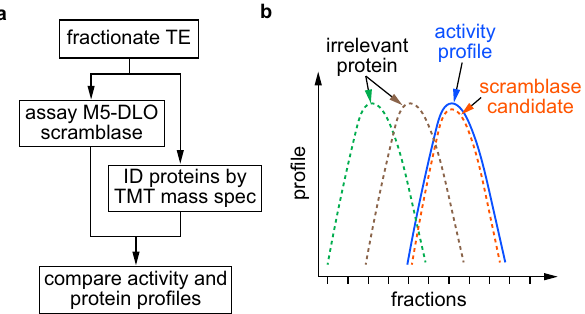
Figure 2. Principle of the activity correlation profiling approach. ( a ) A Triton X-100 extract (TE) of salt- washed yeast membranes, i.e. an extract that is enriched in ER membrane proteins, is fractionated by velocity gradient sedimentation. Half of each fraction is reconstituted into large unilamellar vesicles and assayed for M5-DLO scramblase activity as outlined in Fig. 1b to generate a profile of scramblase activity across the gradient. The remaining half of each fraction is subjected to mass spectrometric analysis using the tandem mass tag (TMT) system. Thus, each fraction is digested with trypsin, and the resulting peptides are labeled with TMT multiplex reagents (a unique TMT mass tag is used for each fraction). The digests are pooled and analyzed by tandem mass spectrometry to quantify the relative amount of identified proteins across fractions, thereby generating protein profiles. The protein profiles are quantitatively compared with the activity profile by obtaining a Pearson correlation score. ( b ) Schematic illustration of the readout from the activity correlation profiling experiment. The activity profile (solid blue line) can be compared to the profile of several different proteins (dashed lines) identified by tandem mass spectrometry. Only a protein whose profile is highly correlated with the activity profile (orange dashed line) is considered as a scramblase candidate. Other proteins that fractionate differently (brown and green dashed lines) are considered irrelevant to scramblase